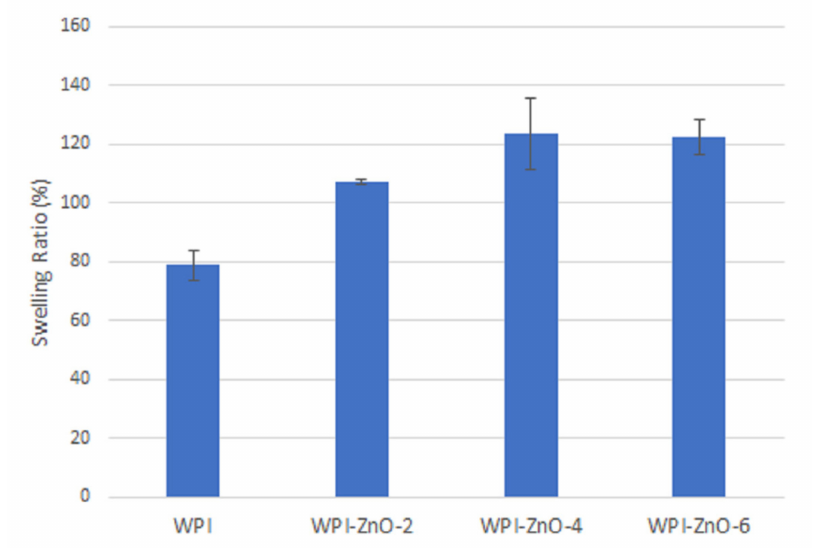
Figure 9. Swelling ratio of WPI and WPI–ZnO composites in